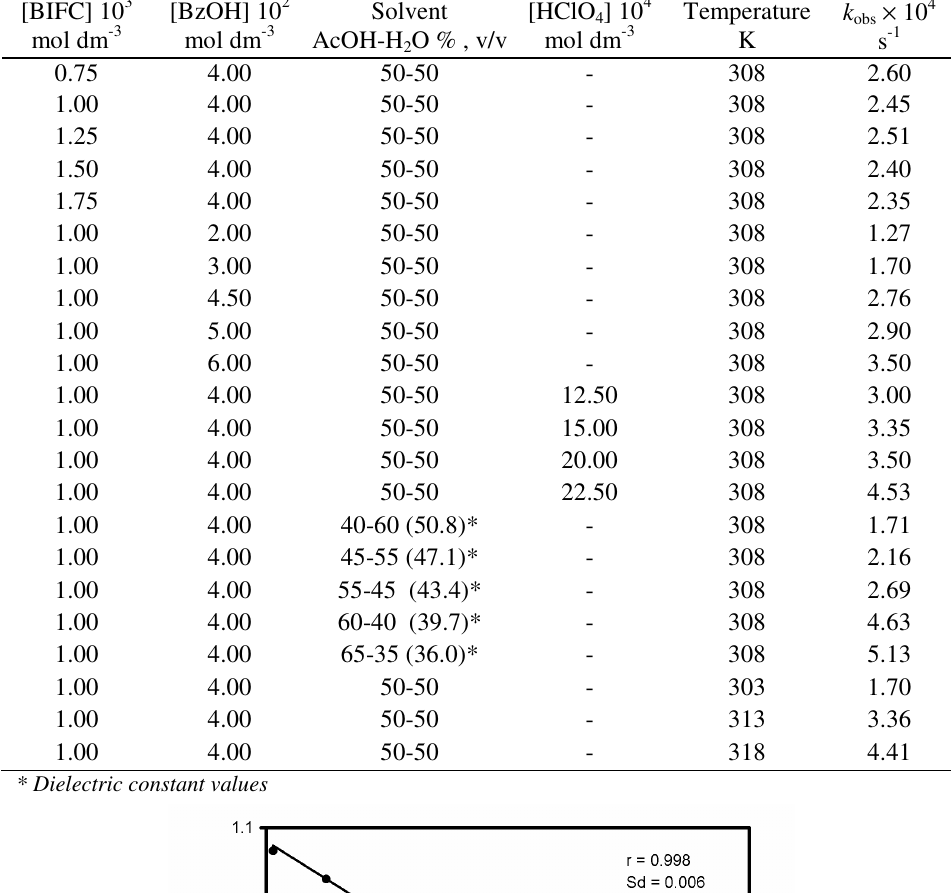
Table 1. Effect of variation of [BIFC], [BzOH], [HClO temperature on the reaction rates